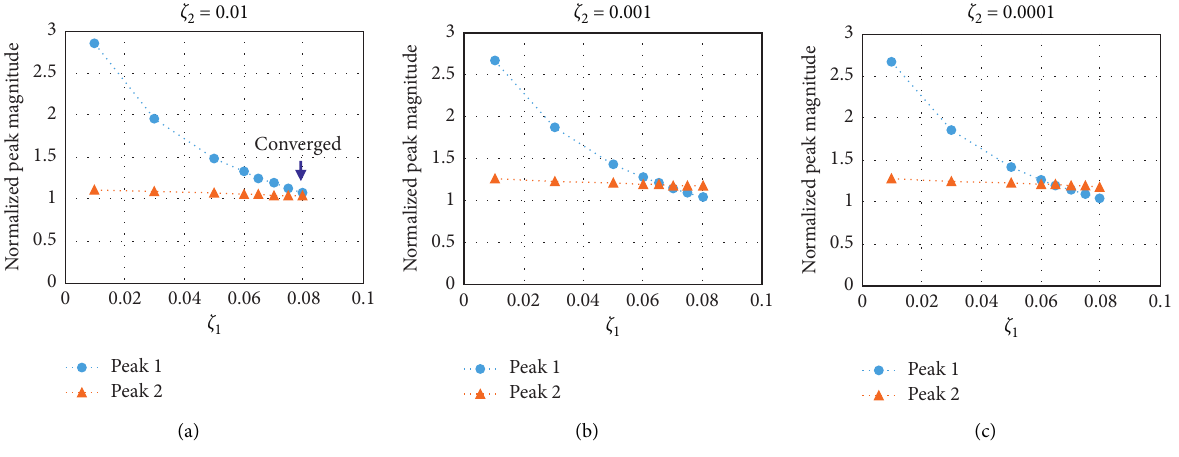
1 for different values of ζ 2 .